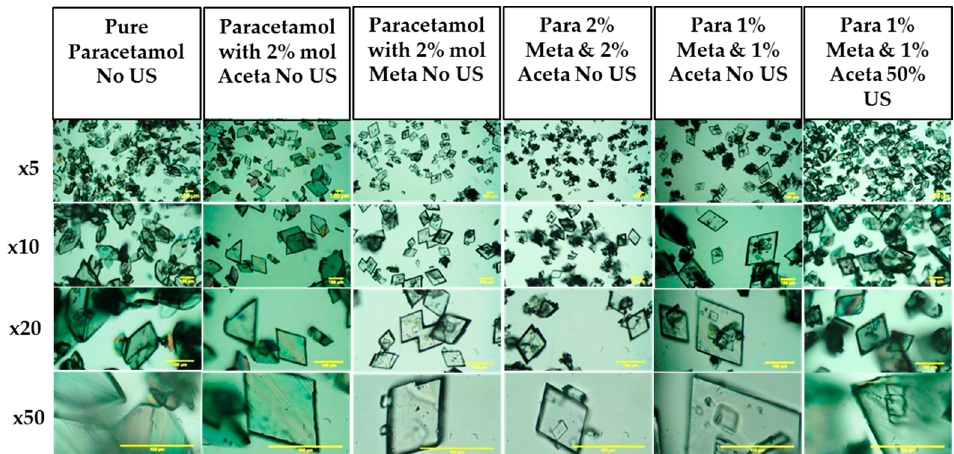
Figure 7. Optical microscopy images of recrystallized paracetamol crystal habit (from the left to the right) for the case of no added impurities with no US, with addition of 2% acetanilide with no US, with addition of 2% metacetamol with no US, with addition of 2% metacetamol and 2% acetanilide with no US, with addition of 1% metacetamol and 1% acetanilide with no US, with addition of 1% metacetamol and 1% acetanilide with 50% US power. Scale bar: 100 µm.